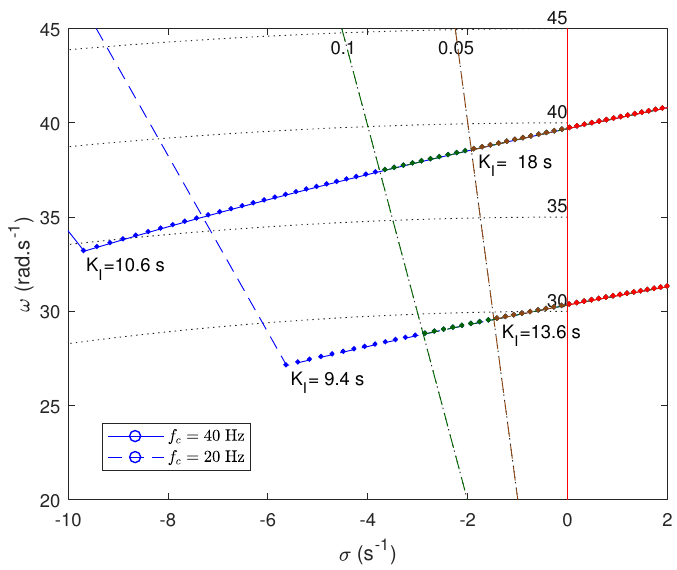
Figure 12. Stability locus of most critical pole indicating maximum value of cumulative virtual inertia gain of all VSGs for given value of f c in the multi-machine system.